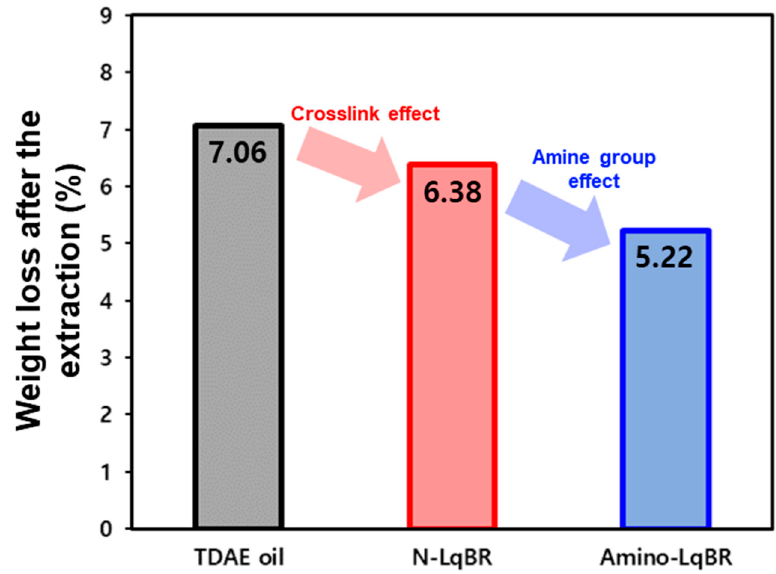
Figure 7. Weight loss after the extraction of the vulcanizates. Table 7. Weight loss after the extraction and crosslink density of the